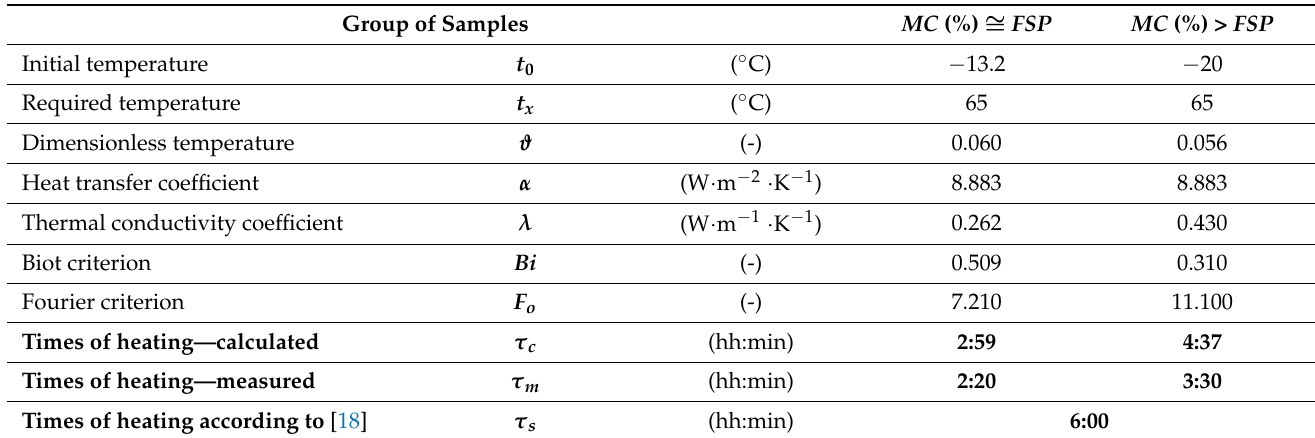
Figure 3. Temperatures of sample in the cross-section, temperature of the environment, and relative humidity of the environment depending on time (heating process). Table 2. Input parameters, values of criterion, and times required to heat